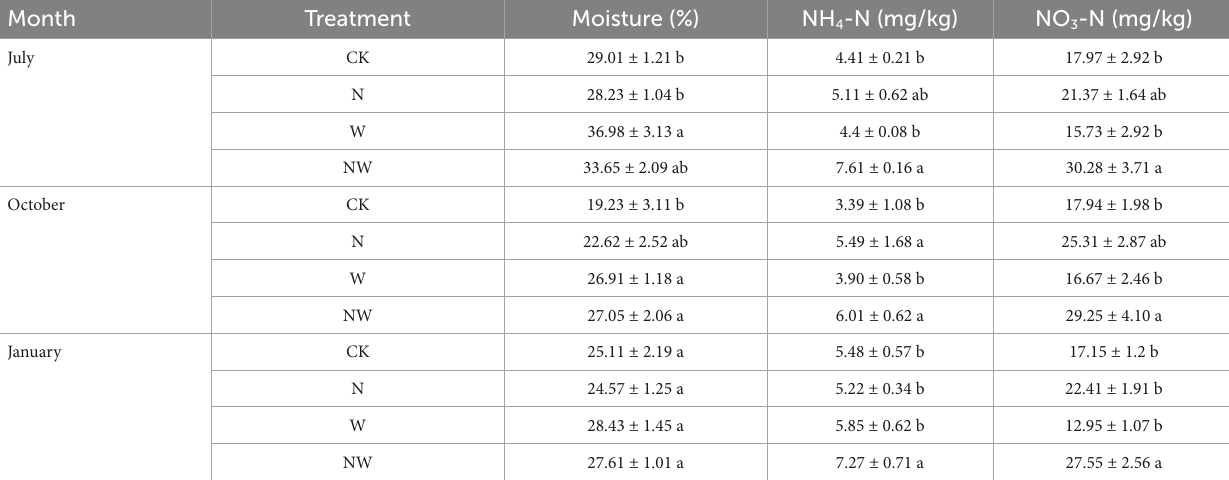
TABLE 3 Soil moisture content and available N (NH 4 -N, and NO 3 -N) content in July 2018, October 2018, and January 2019. Month